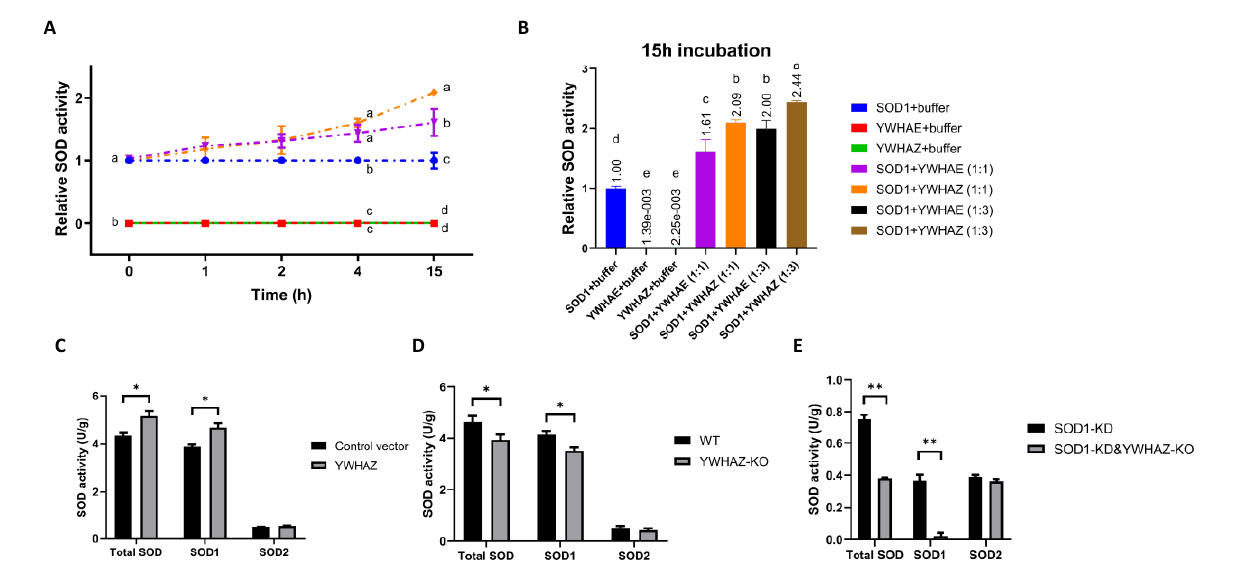
Figure 3. Effects of protein–protein interactions (PPIs) between SOD1 and YWHAE or YWHAZ on SOD1 activity. ( A ) The SOD1 activity in the mixture of SOD1-YWHAE or SOD1-YWHAZ at different incubation time points. The time-point relative SOD activity value was normalized to each time-point “SOD1 + buffer” group’s value. SOD1, YWHAE, and YWHAZ proteins were overexpressed in Pichia pastoris X33 and purified by His-tag affinity beads ( n = 2). ( B ) The SOD1 activity in the mixture of SOD1-YWHAE or SOD1-YWHAZ at different protein ratios for 15 h incubation ( n = 2). ( C ) The total SOD, SOD1, and SOD2 activities of HEK293T cells transfected with the YWHAZ-F2N vector compared with the F2N control vector ( n = 3). ( D ) The total SOD, SOD1, and SOD2 activities of YWHAZ knockout HEK293T cells compared with wild-type HEK293T cells ( n = 3). ( E ) The total SOD, SOD1, and SOD2 activities of YWHAZ knockout and SOD1 knockdown cells compared with the parent SOD1 knockdown cells ( n = 3). *: p < 0.05 and **: p < 0.01. Means within a given time ( A ) and in ( B ) without sharing a common letter differ ( p <